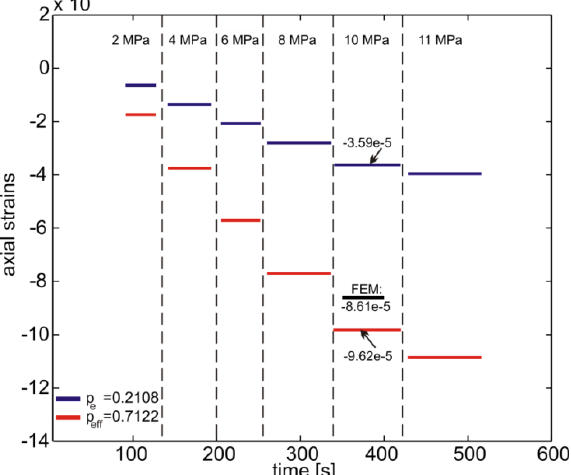
Figure 6. Bare fiber subjected to hydrostatic pressure: comparison between strain calculated from the wavelength shift measurements and Equation (4a) with 0.2108 p  . The vertical dashed lines indicate the application well as Equation (6a) with 0.7122 eff e time of each pressure step. The FE prediction for 10 MPa pressure is also